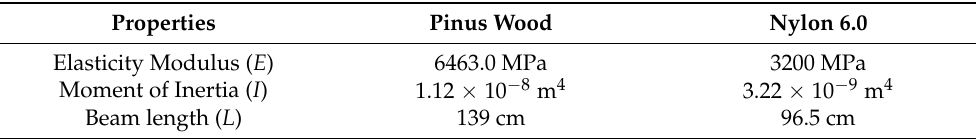
Table 1. Physical and dimensional properties of the beams.